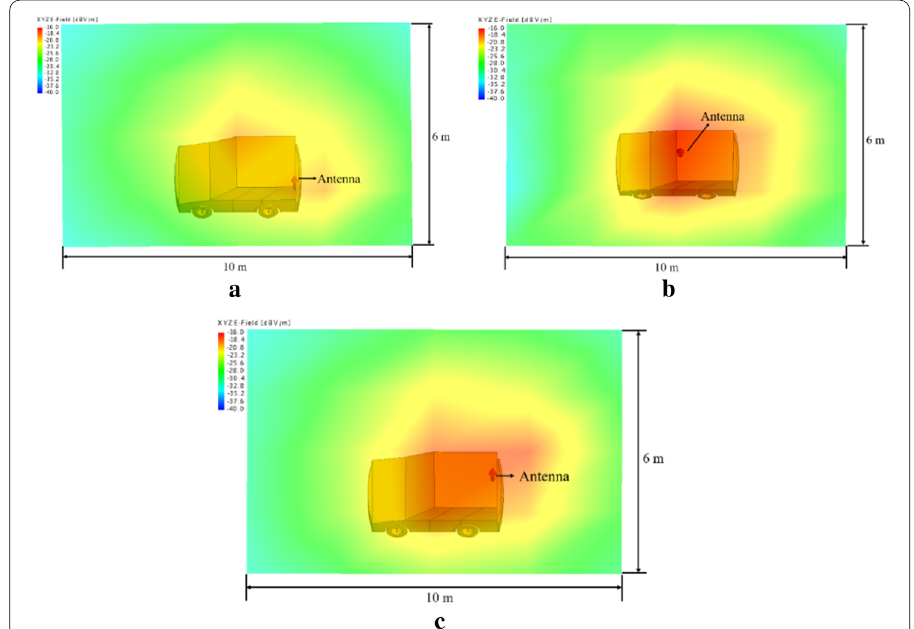
rear edge of the